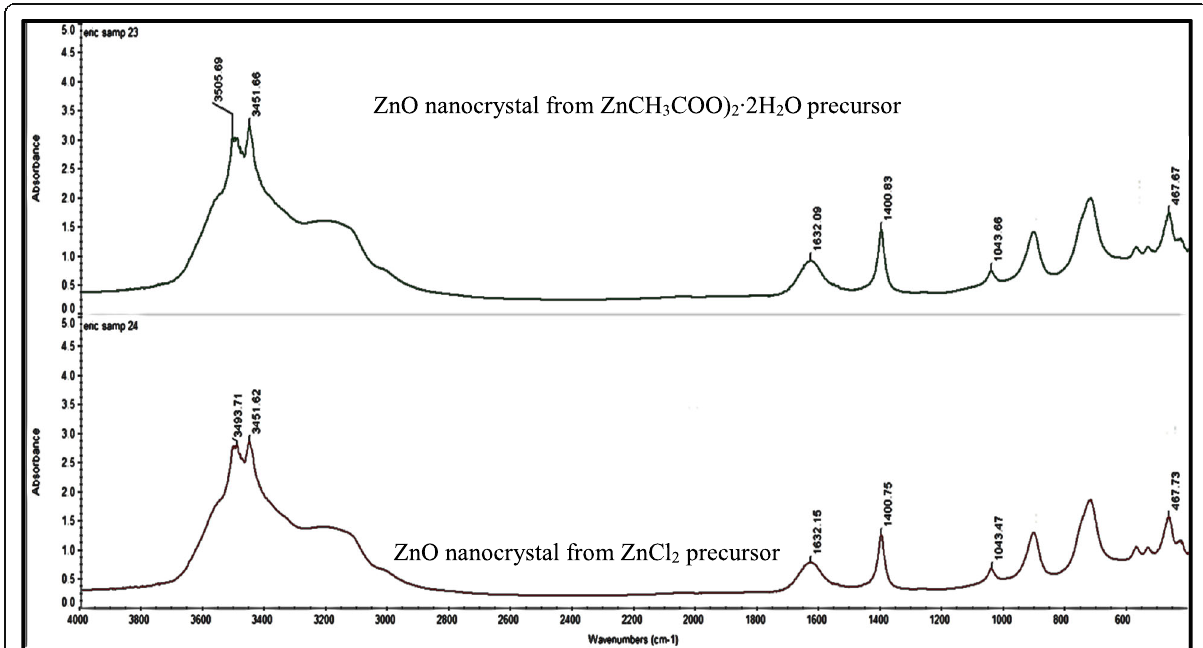
Fig. 1 FT-IR spectra of synthesized ZnO nanoaggregates using Zn(CH 3 COO) 2 ∙ 2H 2 O and ZnCl 2 as precursors